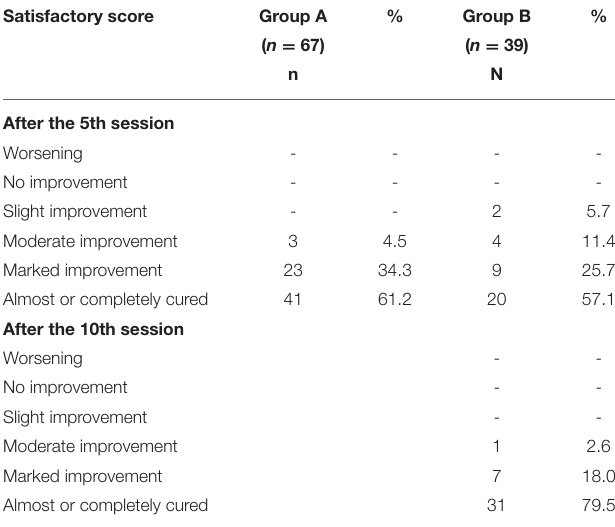
TABLE 4 | Patient-reported improvement